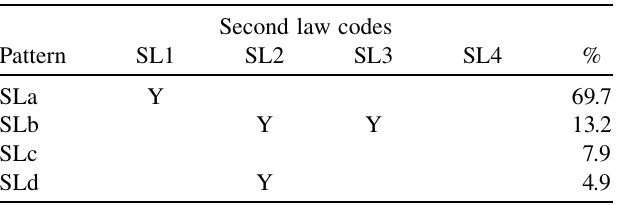
TABLE V. Only four of the nine distinct code patterns for the SL category (Table II) were populated by more than 3% of the students with each pattern is indicated by the last column